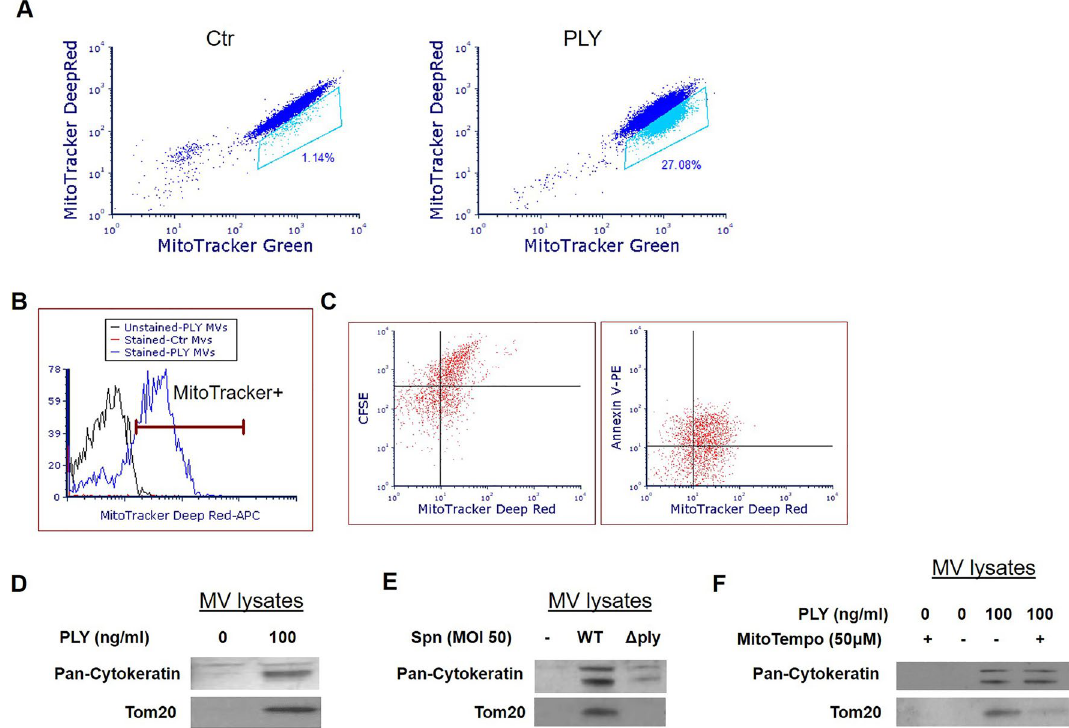
Figure 6. Pneumolysin (PLY) triggers the release of microvesicles (MVs) carrying mitochondrial cargo. ( A ) MitoTracker Deep Red and Green staining of A549 cells after treatment with PLY (100 ng/ml, 4 h) or PBS (Ctr). Gated cells stain less brightly with Mitotracker Deep Red after PLY indicative of loss of membrane potential. ( B,C ) MitoTracker Deep Red-labeled A549 were challenged with PLY (100 ng/ml, 4 h) or PBS. MVs were analyzed by FACS ( B ) or after staining with ( C ) CFSE or annexin V-PE. ( D–F ) A549 were challenged with ( D ) PLY (100 ng/ml, 4 h), ( E ) Spn WT vs Δ ply (MOI 50, 4 h), or ( F ) pre-treated with MitoTempo (50 μM) or DMSO prior to PLY (100 ng/ml, 4 h). MVs were isolated from the conditioned media and analyzed by immunoblotting. Depicted are representative blots of Tom20 (mitochondrial protein) and pan-cytokeratin (cropped images). Experiments were performed 3 or more independent times.